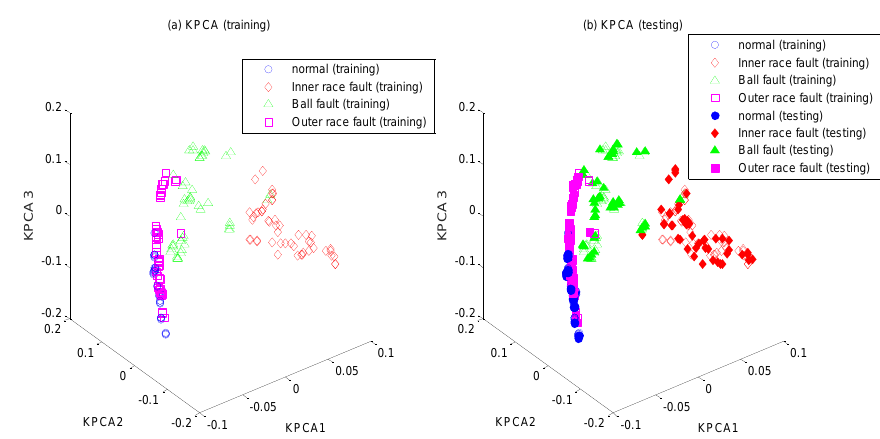
Figure 6. Feature extraction with KPCA: ( a ) training samples, ( b ) testing samples.